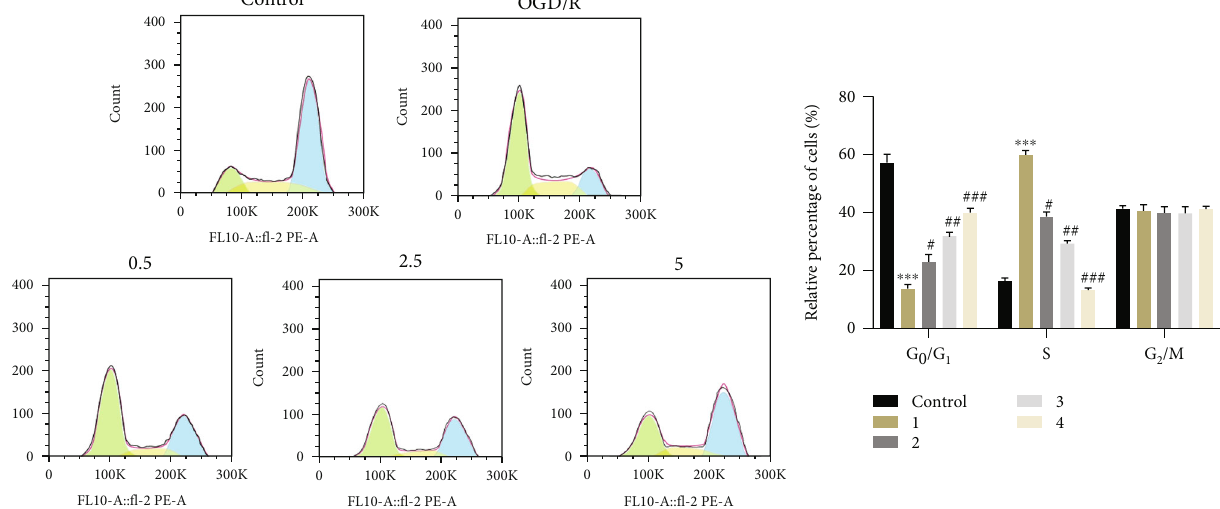
Figure 3: E ff ect of di ff erent concentrations of laminarin (0.5, 2.5, and 5 μ g/ml) on the cell-cycle progression of PC12 cells induced by OGD/R. Note: 1: OGD/R group, 2: OGD+0.5 μ g/ml laminarin group, 3: OGD+2.5 μ g/ml laminarin group, and 4: OGD+5 μ g/ml laminarin group. Compared with the control group, ∗∗∗ P < 0 : 001 ; compared with the OGD/R group, # P < 0 : 05 , ## P < 0 : 01 , and ### P < 0 : 001 .